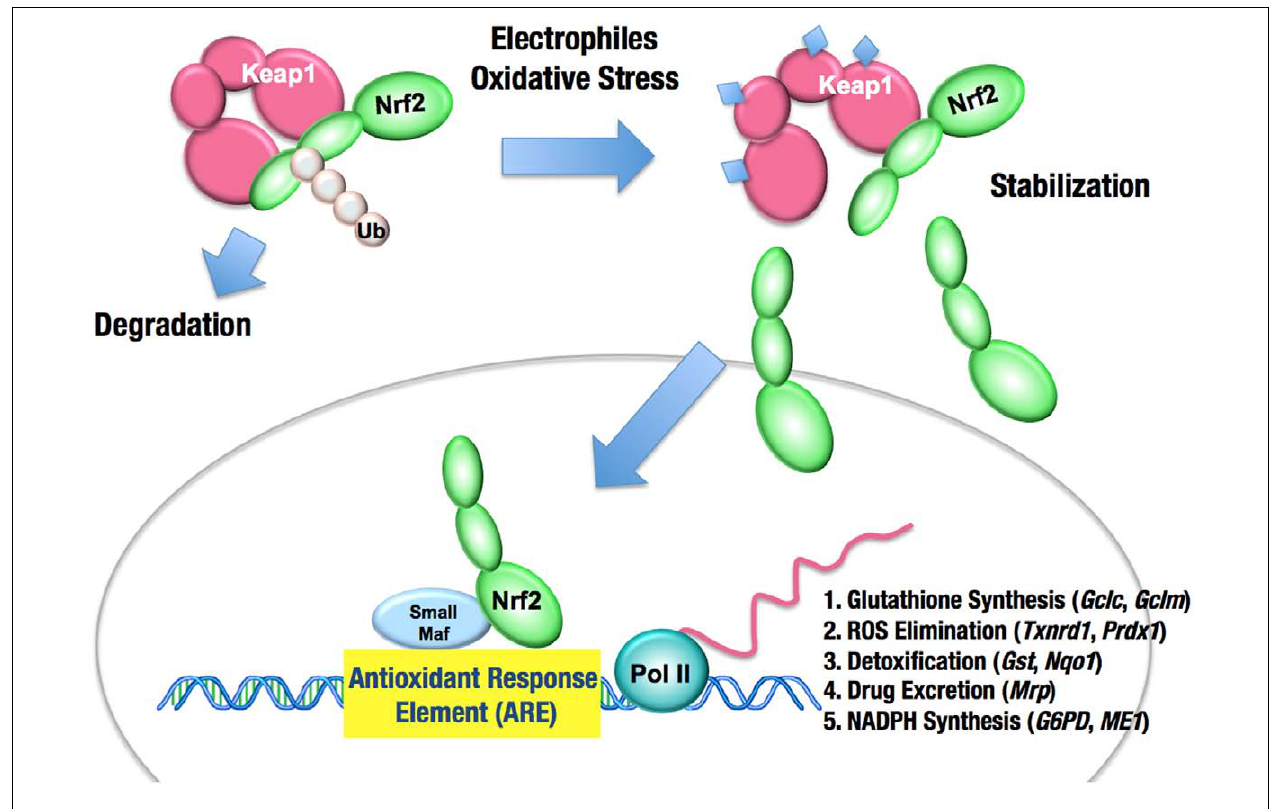
FIGURE 1 |The Keap1–Nrf2 system. Under normal conditions, Nrf2 is constantly ubiquitinated through Keap1 and degraded in the proteasome. Following exposure to electrophiles or oxidative stress, Keap1 is inactivated. Stabilized Nrf2 accumulates in the nucleus and activates many cytoprotective genes. Ub,